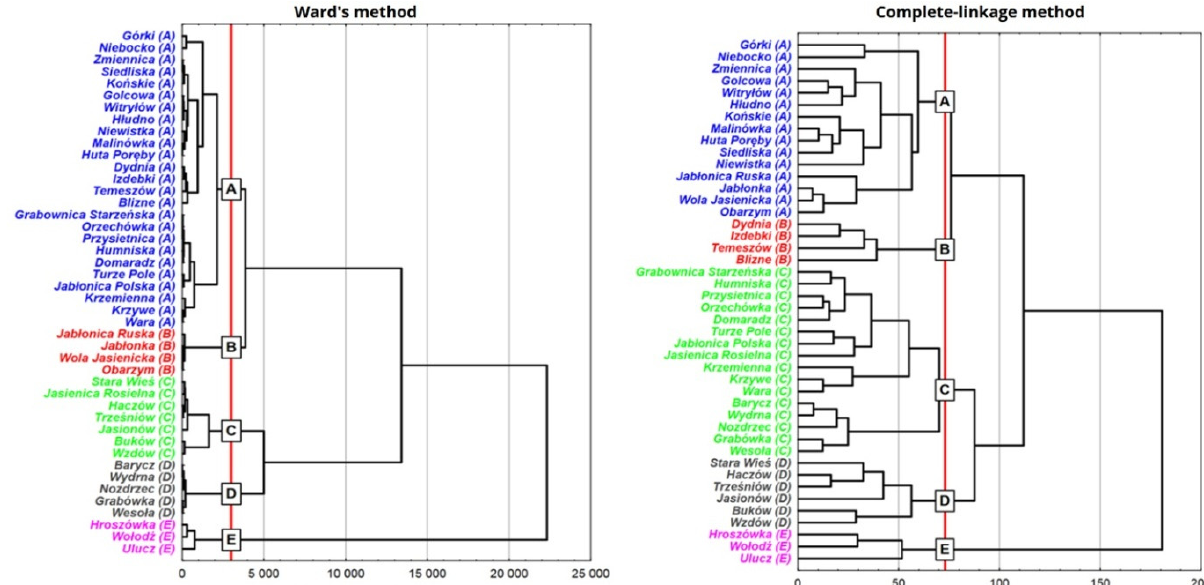
Figure 3. Division of the study area using two statistical methods.